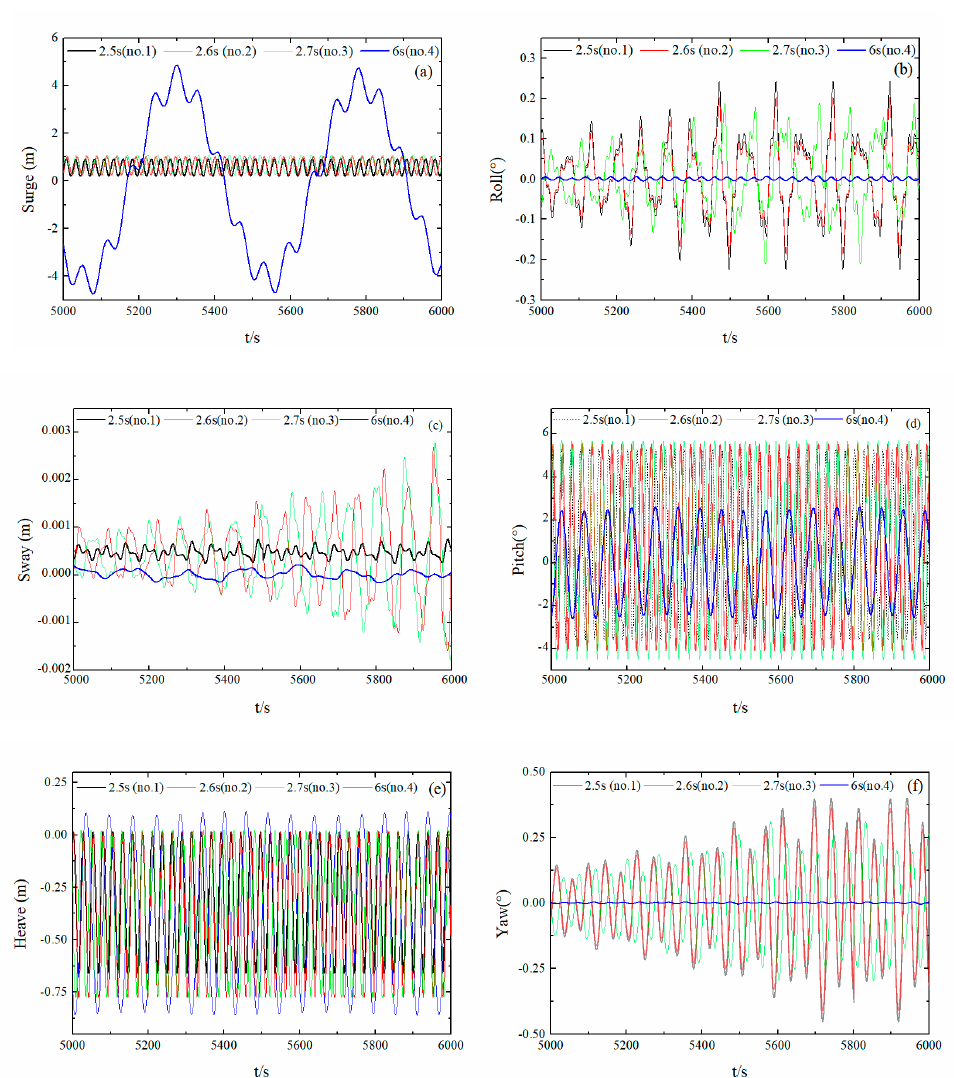
Figure 15. Time-history curves of the 6DoF motion of the float under different wave periods. (Sub-figures: ( a ) surge motion curves; ( b ) roll motion curves; ( c ) sway motion curves; ( d ) pitch motion curves; ( e ) heave motion curves; ( f ) yaw motion curves.)